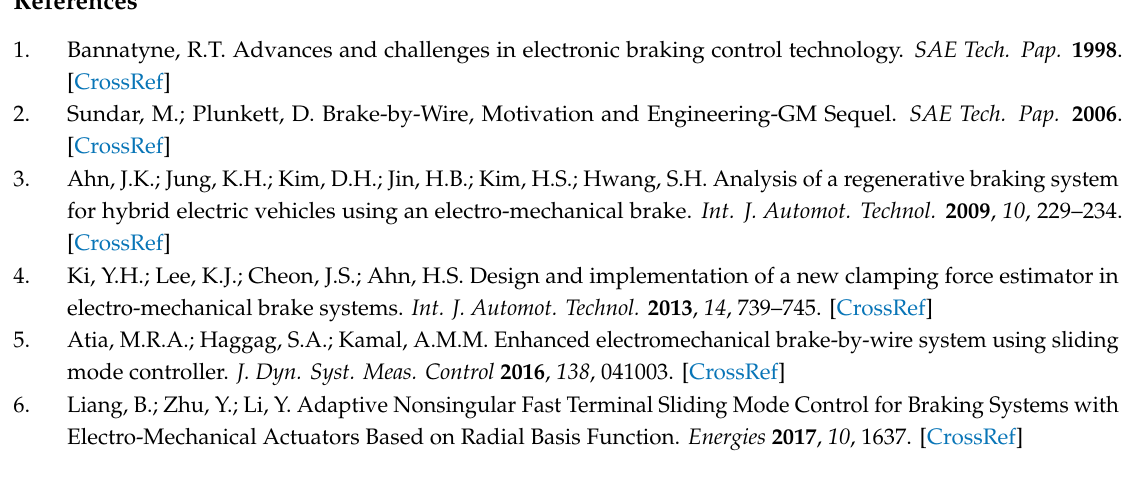
Figure 18. Experimental result of input current: ( a ) without MTPA and ( b ) with MTPA.